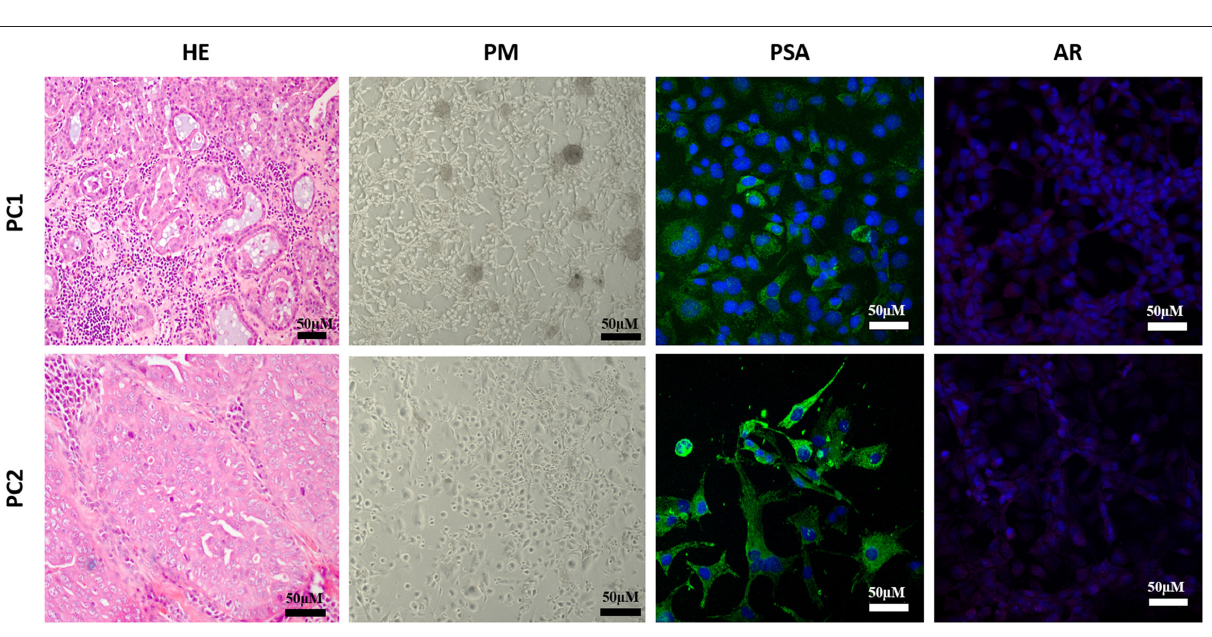
FIGURE 2 | Morphological evaluation of two canine prostatic cell lines (PC1 and PC2). Both originated from Gleason 10PC, with cribriform to solid morphology. In culture conditions, PC1 grew in groups, forming colonies, and tubular-like structures while PC2 grew isolated. The prostatic origin was confirmed by a prostatic-specific antigen (PSA) positive expression, and both were negative for androgen receptor (AR) expression. HE, hematoxylin and eosin; PC, phase